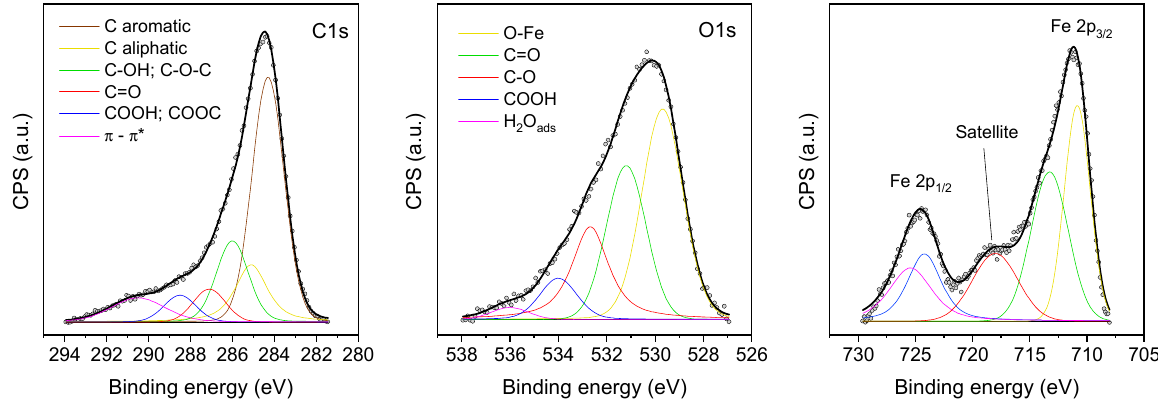
Figure 1. XPS spectra of C1s, O1s, and Fe2p region for Fe/CN-B catalyst. All the Fe/AC- f catalysts present analogous signals.